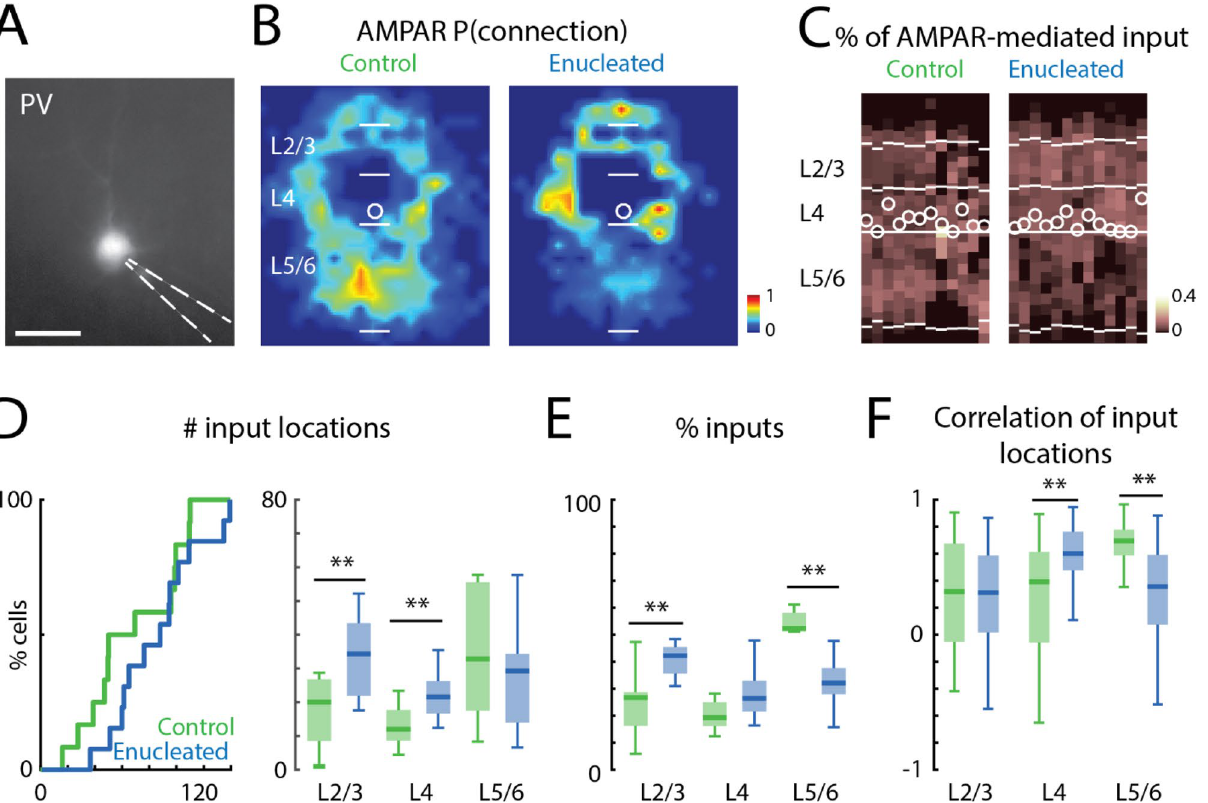
Figure 6. AMPAR-mediated cortical inputs to PV interneurons from supragranular layers are increased after enucleation. ( A ) An example PV-Cre::tdTomato interneuron under epifluorescence microscopy. Scale bar = 50 µm. ( B ) Average spatial connection probability maps of AMPAR-mediated inputs to L4 PV interneurons in V1 at P16/P17 in control and enucleated animals (enucleated at P1) (n = 12 control and n = 13 enucleated). Maps show the fraction of cells that received an input from a particular spatial location. The length of the scale bars marking the layer boundaries is 100 μm. ( C ) Laminar distribution of inputs for each cell. Plotted is the fraction of input each cell received at each laminar location. Layer borders for each cell are indicated by horizontal white lines. Soma locations are indicated by white circle; cells are aligned to L4. ( D ) Quantification of the number of input locations. CDF of the total number of input locations (left). Boxplot shows the number of input locations in each layer group (right). AMPAR-mediated inputs from L2/3 and L4 are increased after enucleation. (**) indicates P < 0.01, otherwise P > 0.05. ( E ) Boxplot of the average fraction of inputs from each layer. The fraction of L5/6 inputs is decreased while the fraction of L2/3 inputs is increased after enucleation. (**) indicates P < 0.01, otherwise P > 0.05. ( F ) Boxplot of the correlation of input locations from each layer originate. (**) indicates P < 0.01, otherwise P > 0.05. Statistics for ( D ) (left) are in the main text. Statistics for ( D ) (right), ( E ) and ( F ) are in Table